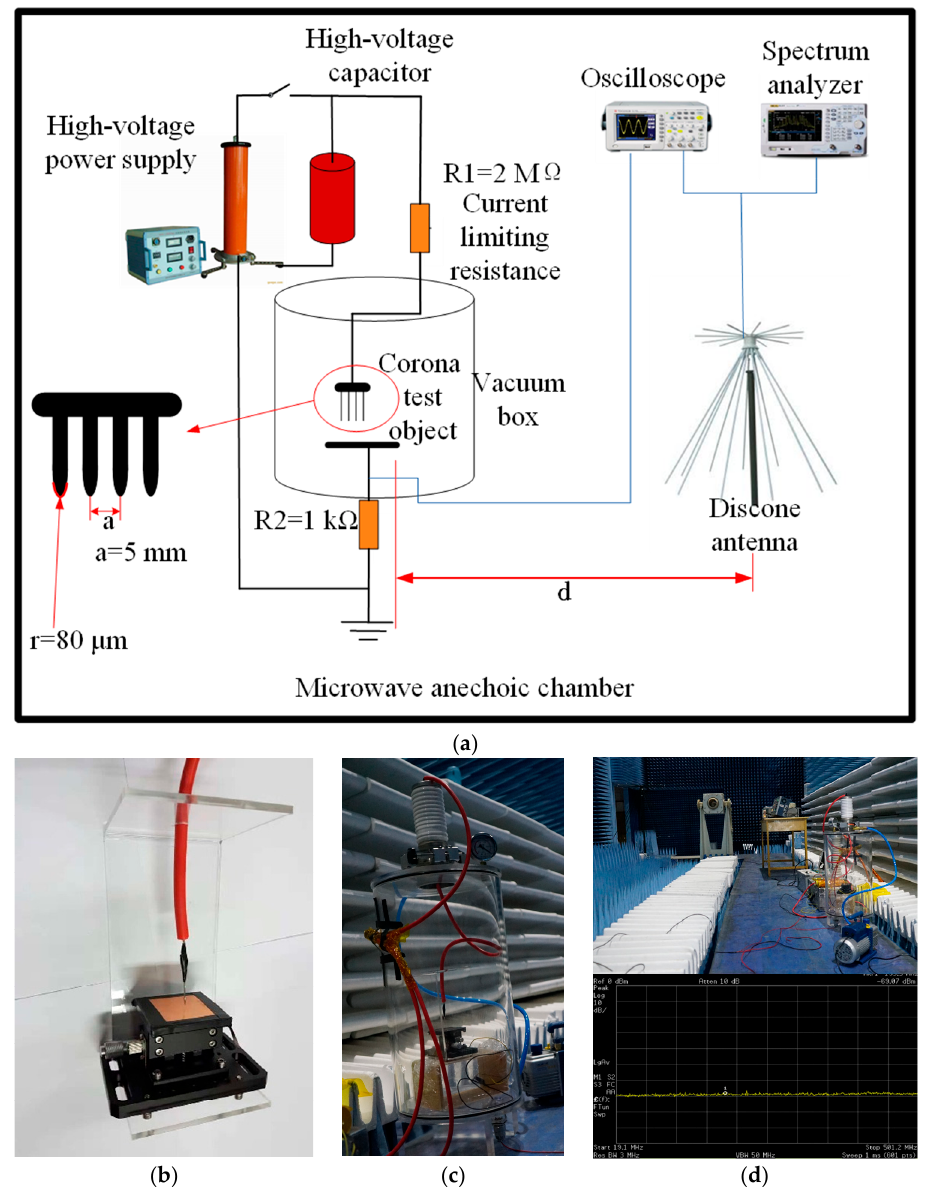
Figure 1. Experimental set-up: ( a ) Schematic of the experimental set-up; ( b ) Corona discharge object; ( c ) Vacuum box; and, ( d ) Photograph of the experimental set-up and background electromagnetic (EM) noise of microwave anechoic chamber.